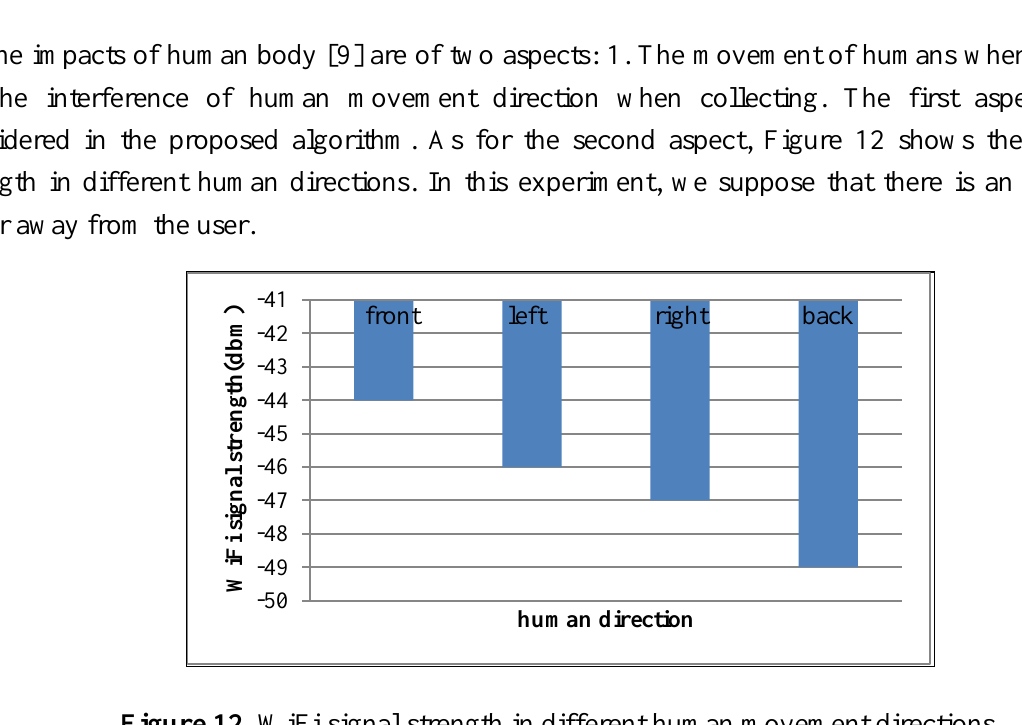
Figure 12. WiFi signal strength in different human movement